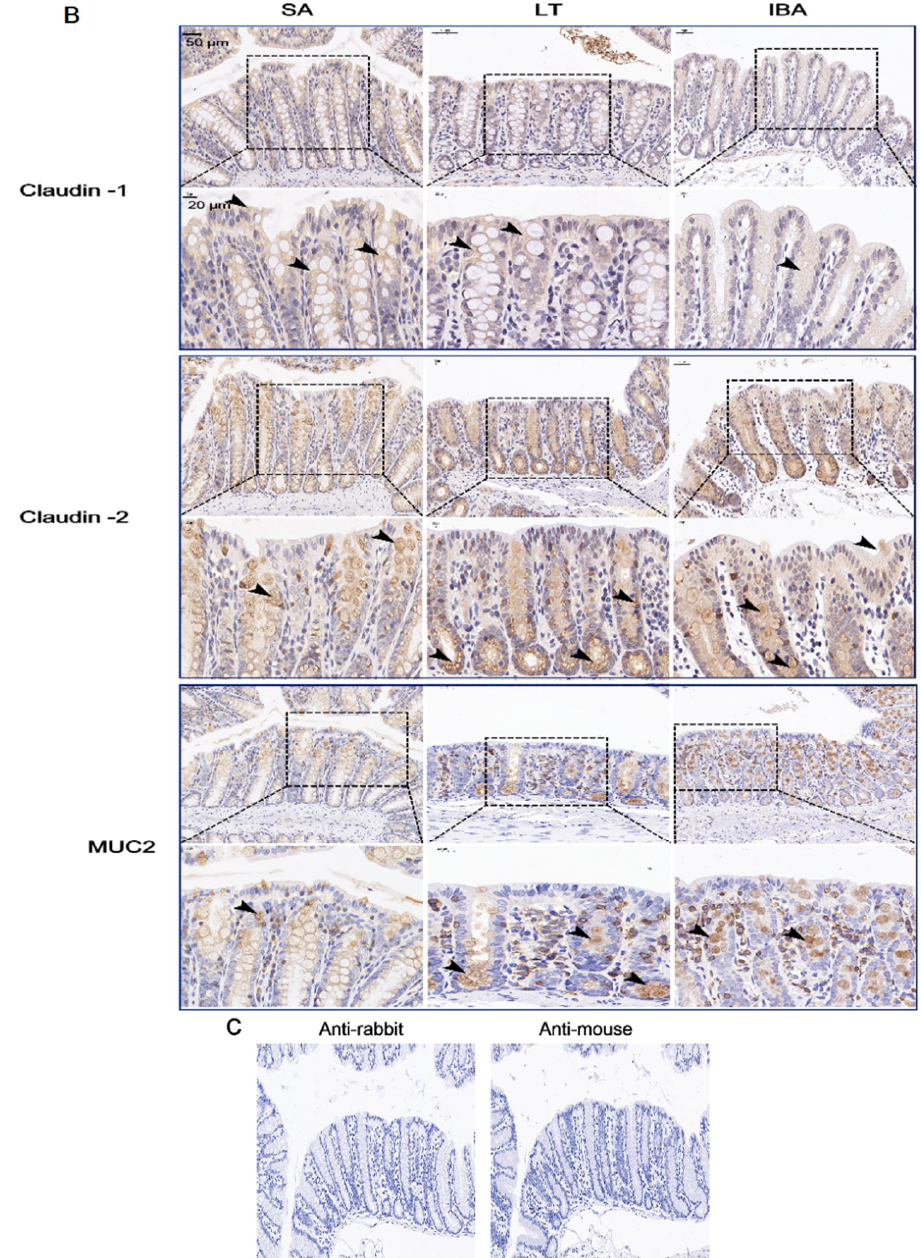
Figure 9. ( A ) Immunohistochemical staining of colonic mucosal occludin, ZO-1, and E-cadherin proteins in Daurian ground squirrels. ( B ) Immunohistochemical staining of colonic mucosal claudin-1, claudin-2, and MUC2 proteins in Daurian ground squirrels. ( C ) Negative control (all steps and conditions are the same, except that the primary antibody is not added and the secondary antibody is different). Hematoxylin-labeled the nucleus (blue), DAB staining positive when brownish yellow (black arrows). n = 3. SA, summer active; LT, late torpor; IBA, interbout arousal.